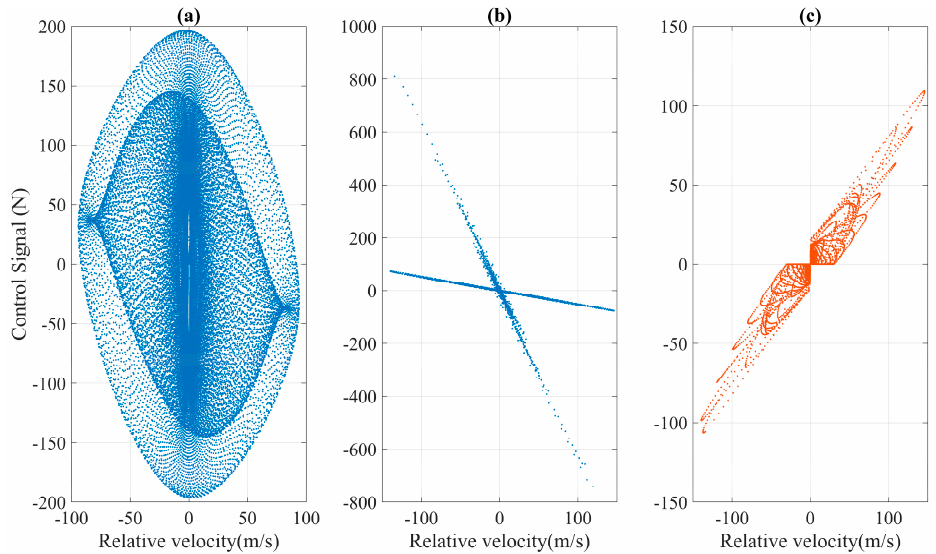
Figure 4. Control signals as a function of relative velocity for the ( a ) purely active system; ( b ) semi-active component; and ( c ) active component of the hybrid configuration subjected to a white noise excitation.